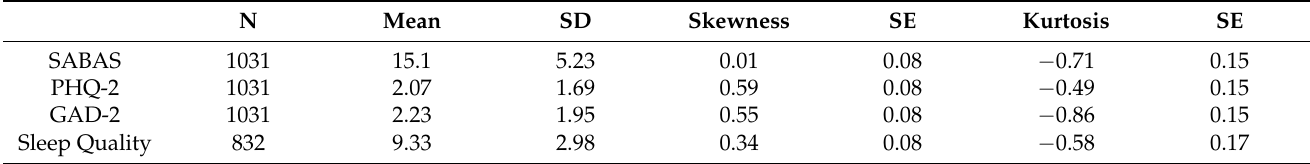
Table 1. Descriptive statistics for each measure.